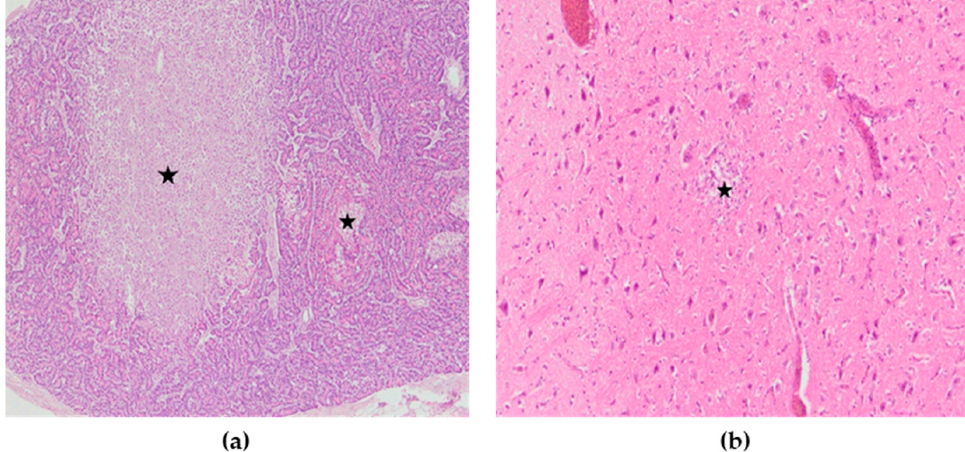
Figure 6. ( a ) Lungs, severe vascular congestion. H&E × 100. ( b ) Heart, myocardial degeneration, H&E × 200.